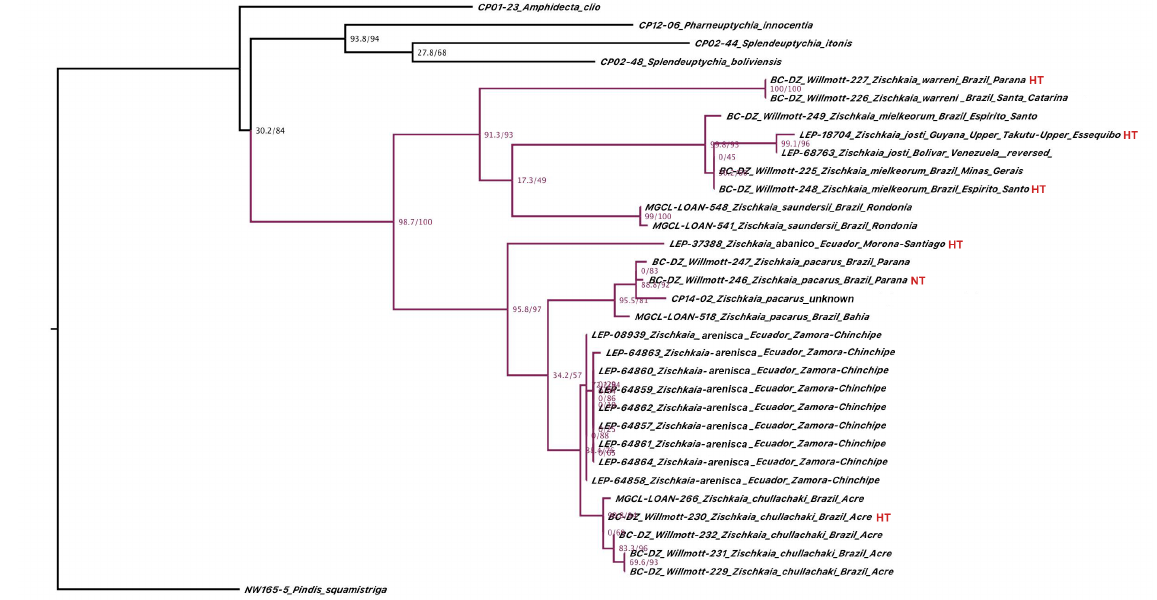
Fig. 1. Likelihood tree with the best log-likelihood score (-LnL = -2536.1613) given our data based on DNA ‘barcodes’, depicting Zischkaia as a well-supported clade. Support values are represented by SH- aLRT/UF Bootstrap. Abbreviations: HT = Holotype; NT =